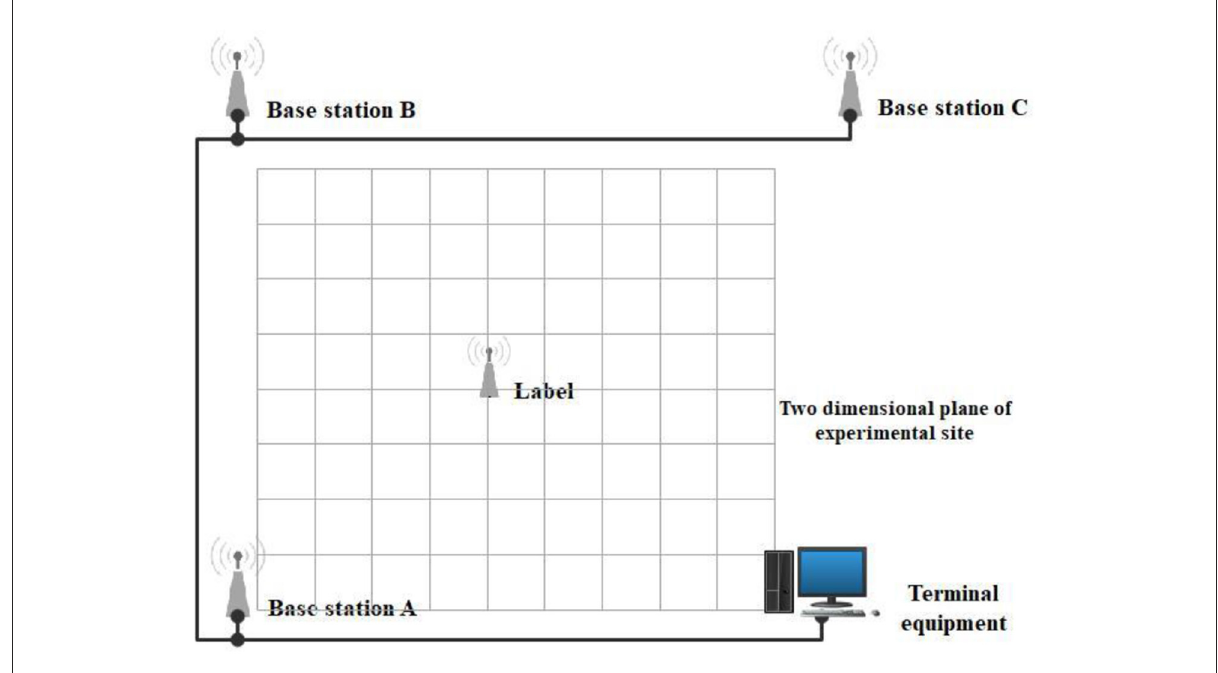
FIGURE10 A representation of the simulation process at the experimental site.